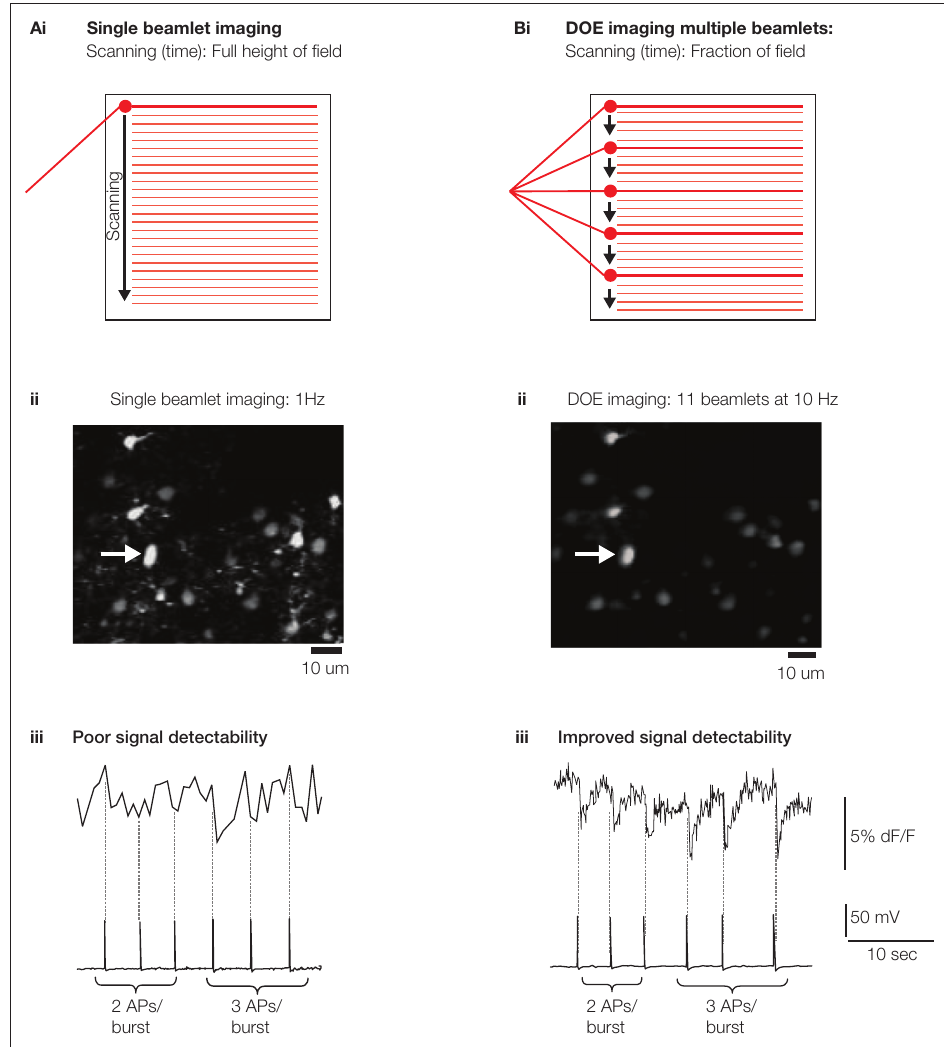
Figure 2 | Diffractive optical element (DOe)-based high-speed imaging. Adapted from Watson et al. (2009). (Ai) schematic of traditional single beam imaging requiring that a single beam scan of all lines to be imaged necessitating a relatively long scan time per frame. (Bi) Multiple beamlets created by the DOE (each as powerful as the single beamlet used for single beam imaging) simultaneously sweep the field with each beamlet covering a small portion of the territory to quickly excite the entire field of view. (Aii) Image created by scanning across a population of calcium indicator-loaded cells (Fura 2-AM) using single beam scanning and photomultiplier tube detection. Scanning at this resolution and mirror sweep speed was 1 Hz at the fastest. (Bii) DOE 10 Hz scanning of same field of with 11 beamlets and with light gathering using a CCD camera at the same mirror sweep speed. (Aiii) Calcium indicator fluorescence recorded with single beam imaging from a patch clamped neuron indicated by arrow in (Aii) . Above: calcium indicator fluorescence versus time of the patch clamped neuron. Below: electrophysiological tracing recorded simultaneously from the same cell as was being imaged, demonstrating periods of induced action potential generation. The first three action potential bursts have two action potentials per burst and are undetectable in the calcium indicator brightness trace, the later bursts have three action potentials each give somewhat clearer signals in the calcium indicator tracing. (Biii) Imaging of calcium transients at 10 Hz using DOE imaging. Bursts of either two or three action potentials are easily detectible in this higher speed scheme, likely due increased sampling rate. All imaging at 800-nm light with detection at 510